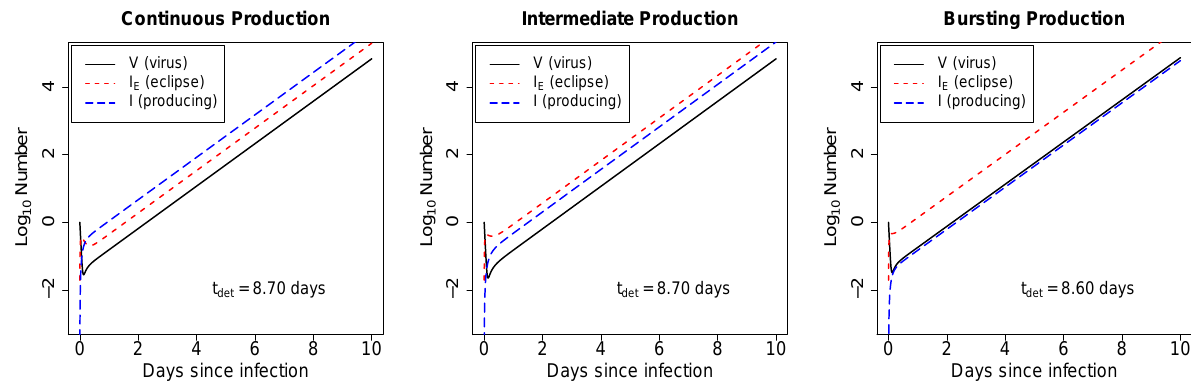
Figure 2. For biologically reasonable parameter values, the mode of virus production by infected cells has little impact on the time to virus detection in deterministic simulations. We solve the mathematical model (Equations (1)–(3)) numerically and plot predicted values for the infectious virus ( V ), infected cells in the eclipse phase ( I ), and virus-producing cells ( I ). E Time courses are shown for the model with continuous-mode virus production (short eclipse phase, left panel), intermediate mode virus production (eclipse phase takes approximately half of the life-span of infected cells, middle panel), and bursting mode of virus production (long eclipse phase, right panel). Parameters used are given in Table 1. All infections are = 1 . The time of virus detection, t started with V , is the time when the virus population 0 det = 10 4 infectious viruses and is indicated on individual reaches V det